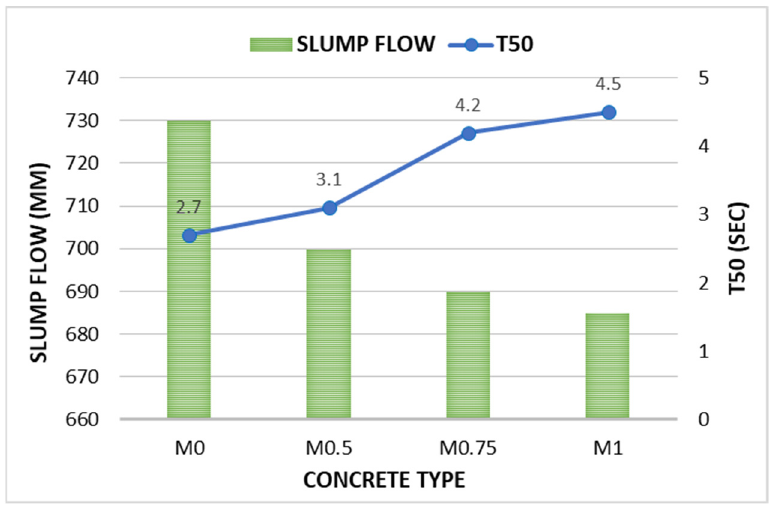
Figure 6. Slump flow value and T50 time period for different type of SCC mix.